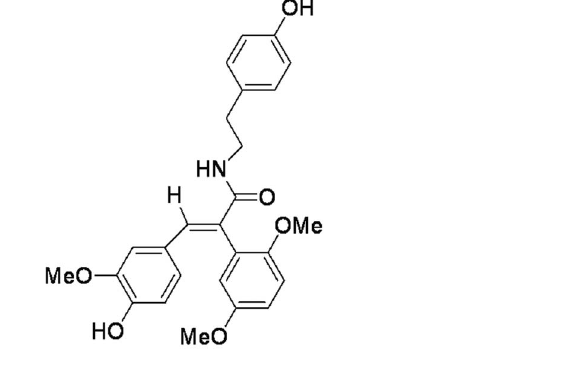
Figure 1. Chemical structure of FLZ, N-[2-(4-hydroxy-phenyl)- ethyl] -2-(2,5-dimethoxy-phenyl)-3-(3-methoxy-4-hydroxy- phenyl)-acrylamide.